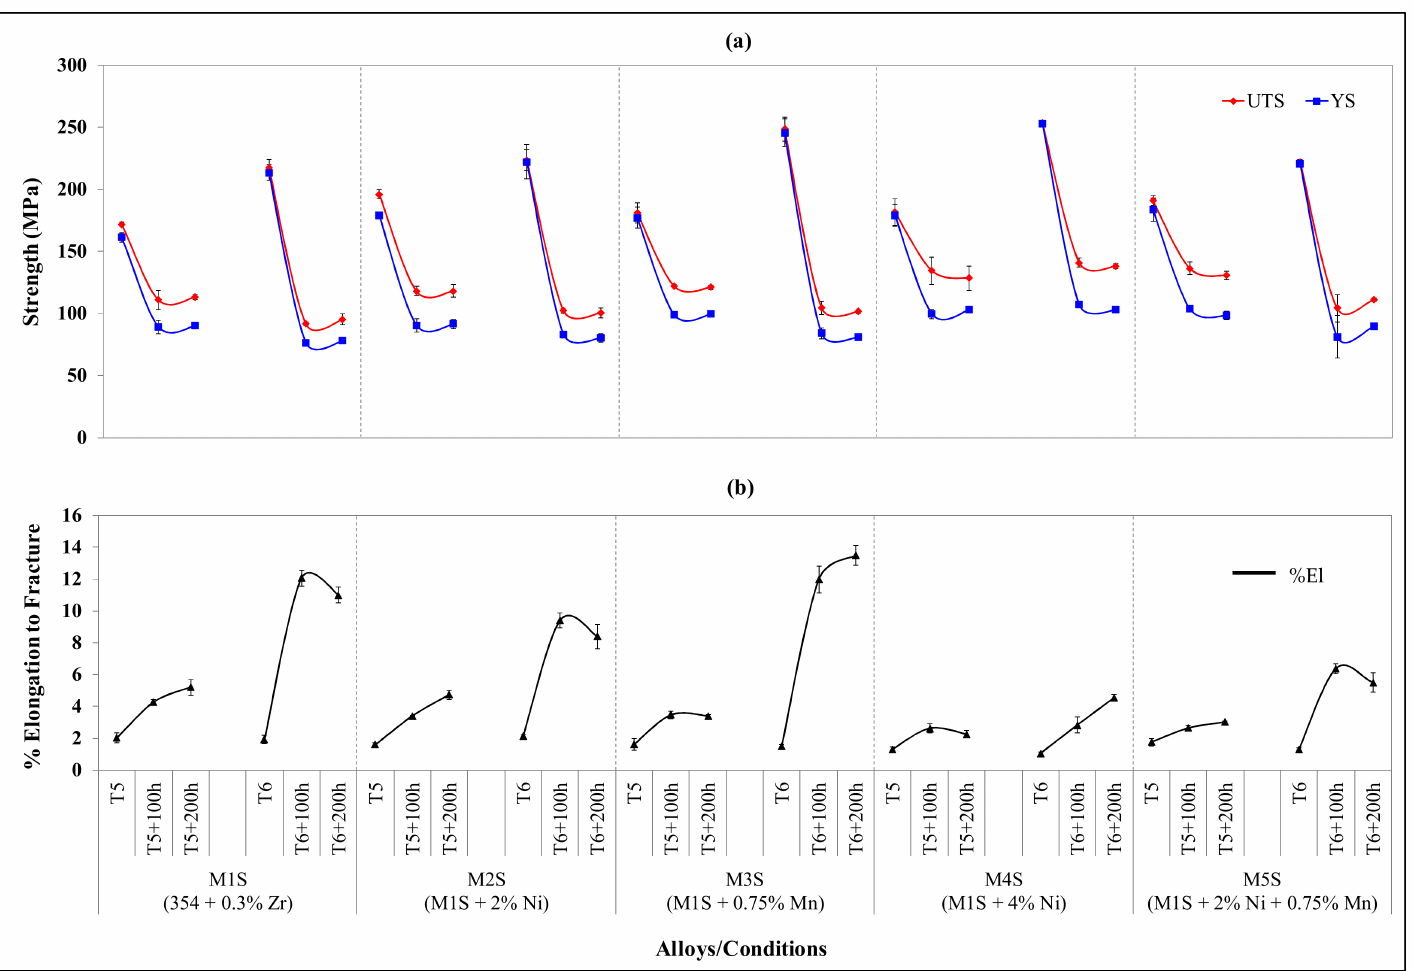
Figure 4. Variation in average UTS, YS, and %El values for alloys M1S through M5S in the T5 and T6, and after stabilization at 250 ◦ C for 100 h and 200 h (testing at 250 ◦ C). ( a ) UTS and YS; ( b )